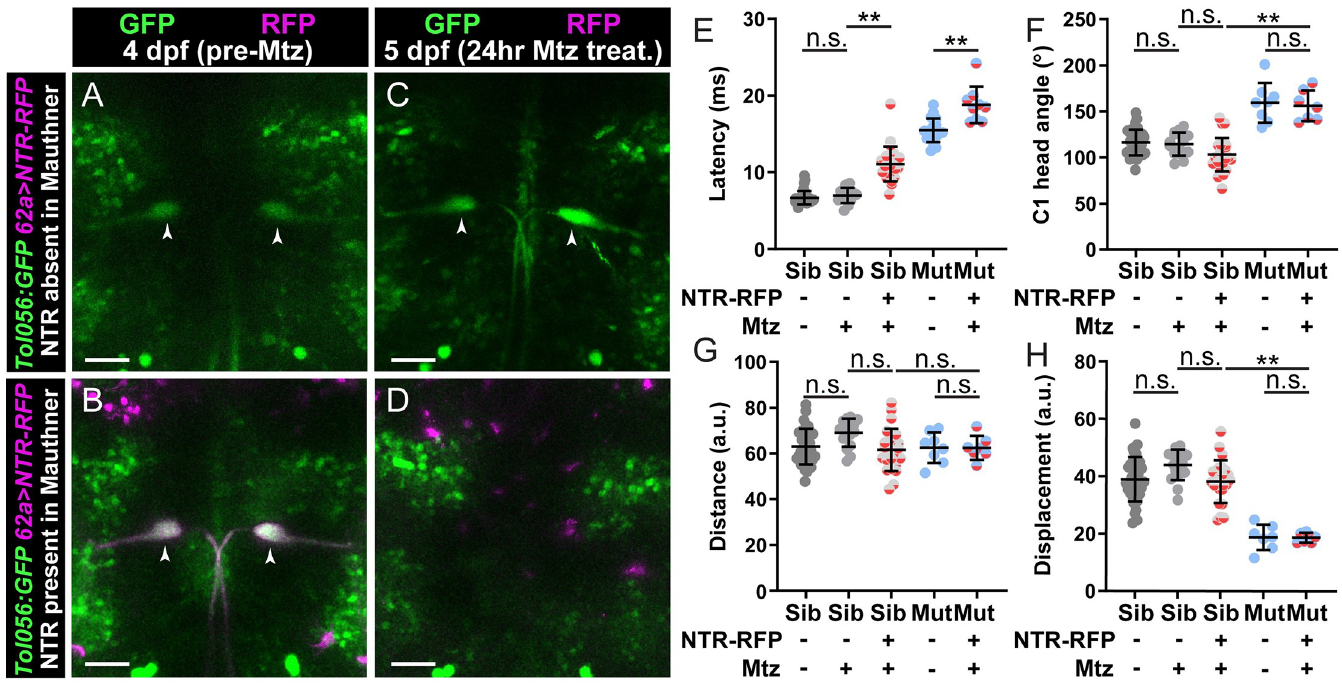
Fig 5. Kv1.1 functions outside the Mauthner command neuron to control swim movement magnitude. (A-D) kcna1a mutants expressing Tol056 (GFP in Mauthner cells; green), 62a : Gal4 (Mauthner specific) and UAS : NTR-RFP (magenta). 62a > NTR-RFP is mosaic so some fish do not display expression in Mauthner cells (A) while others do (B). Before treatment with metronidazole (Mtz) at 4 dpf, all fish have GFP+ Mauthner cells (A,B). After 24 hr Mtz treatment, Mauthner cells are present in fish without initial NTR-RFP Mauthner expression (C) and absent in fish that displayed initial Mauthner NTR-RFP expression (D). (E-H) Kinematic parameters of the acoustic startle response in kcna1a sibling and mutant larvae with or without NTR-RFP expression in Mauthners and with or without Mtz treatment. Each point is the average response over ten trials for an individual larva. n � 9 larvae, �� p < 0.0001 (one-way ANOVA with Tukey correction for multiple comparisons). Scale bars = 50 μ